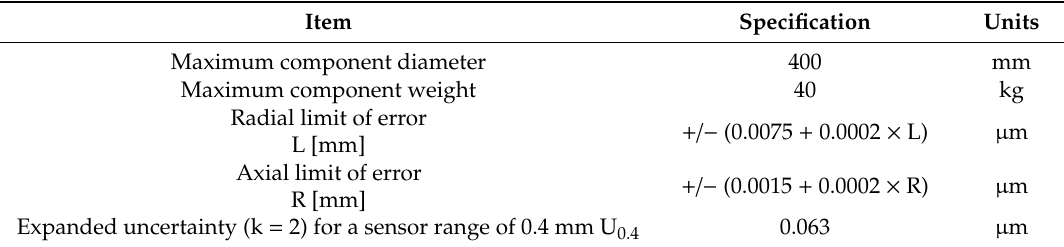
Figure 5. Geometric errors of the three-axis vertical machining centre [5].